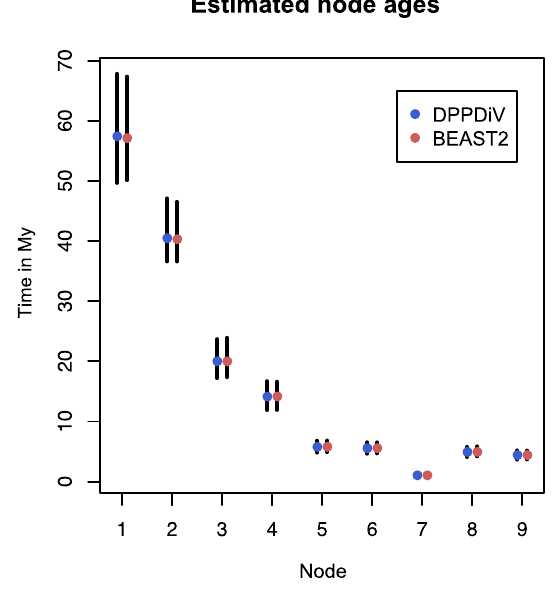
Figure 7. Divergence time estimates for the bear dataset. The estimates are obtained from the analyses with DPPDiv [30] (left bars with blue dots) and BEAST2 (right bars with red dots) implementations of the fossilised birth-death model, which give the same results. The bars are 95% HPD intervals and the dots are mean estimates. The node numbering follows the original analysis [30]: nodes 1 and 2 represent the most recent common ancestors of the bear clade and two outgroups (gray wolf and spotted seal). Node 3 is the most recent common ancestor of all living bear species and nodes 4-9 are the divergence times within the bear